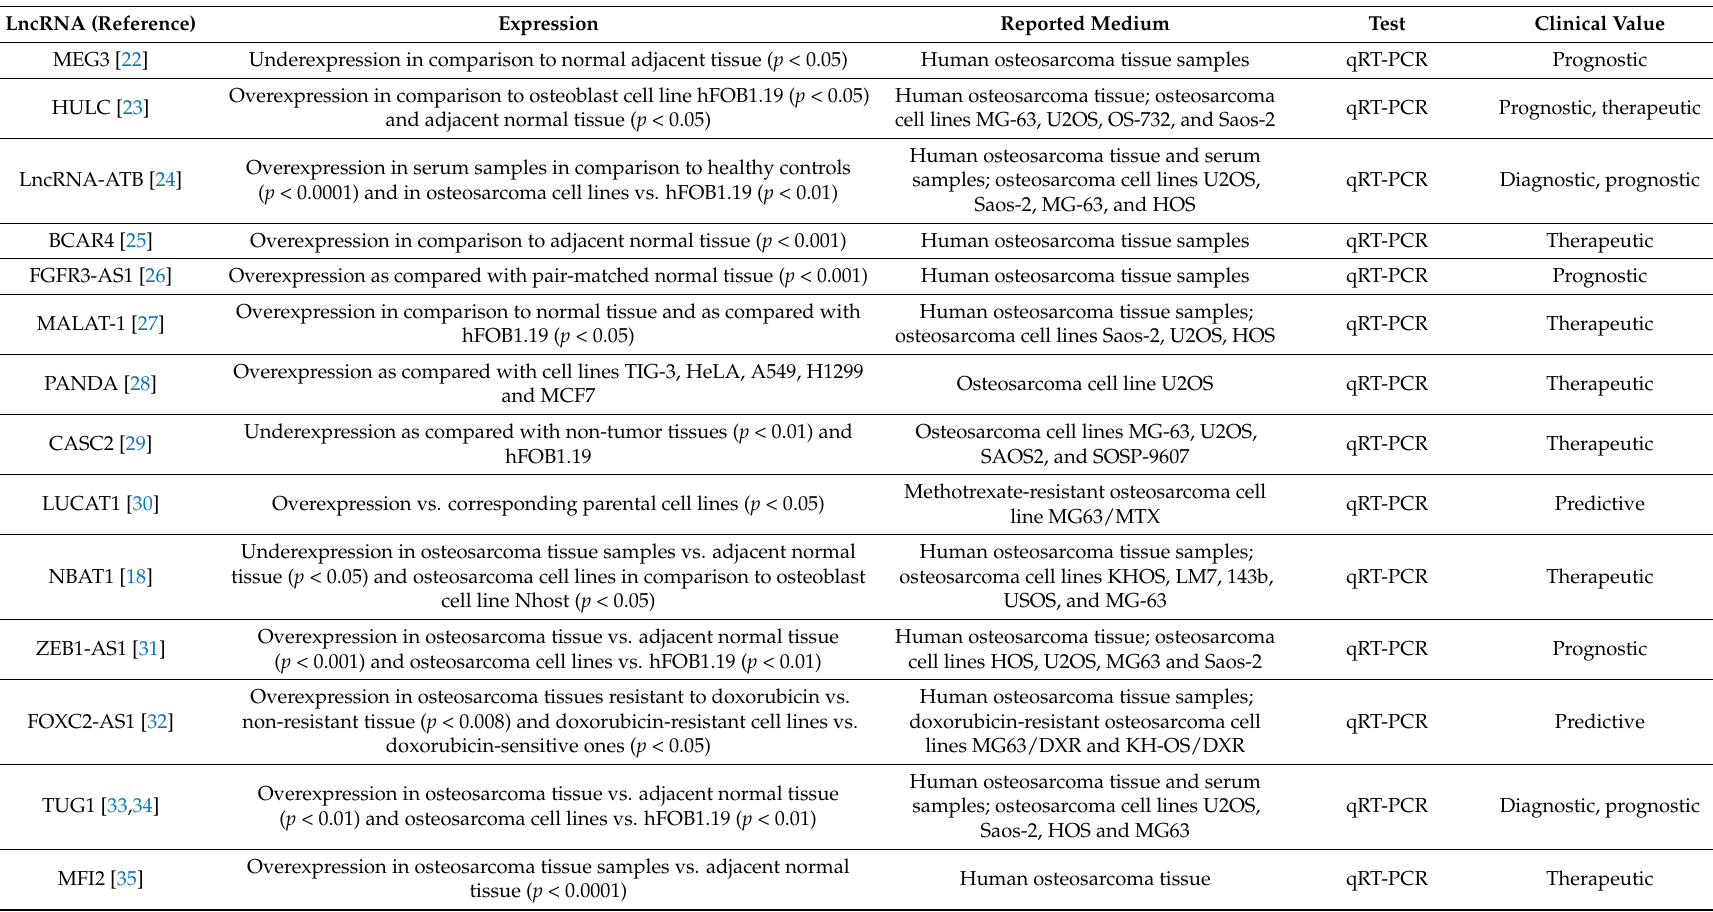
Table 1. Clinical value of lncRNAs involved in the pathogenesis and progression of